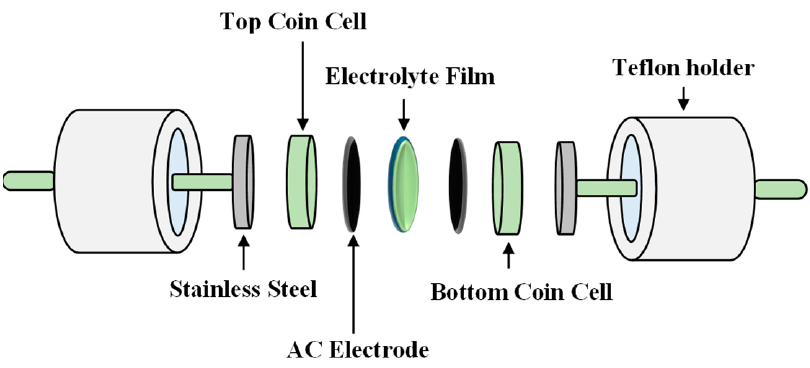
Figure 10. Schematic diagram of the electrochemical double ‐ layer capacitor (EDLC) setup. There are invisible peaks related to the occurrence of the oxidation or reduction process in the CV plot [100]. No redox peak can be seen in the CV plot, representing the occurence of a charge double-layer at the surface of activated carbon electrodes, that is, capacitive performance [42,48]. The leaf-like shape of the CV curve is observed at a higher scan rate turned to a rectangular-like shape when the scan rates are reduced. The factors that affect these changes could be the porosity of carbon electrodes and the internal resistance presence during the scanning process [101,102]. The non-Faradaic process means the EDLC’s charge storage mechanism depends on ion buildup at the interfaces between electrodes